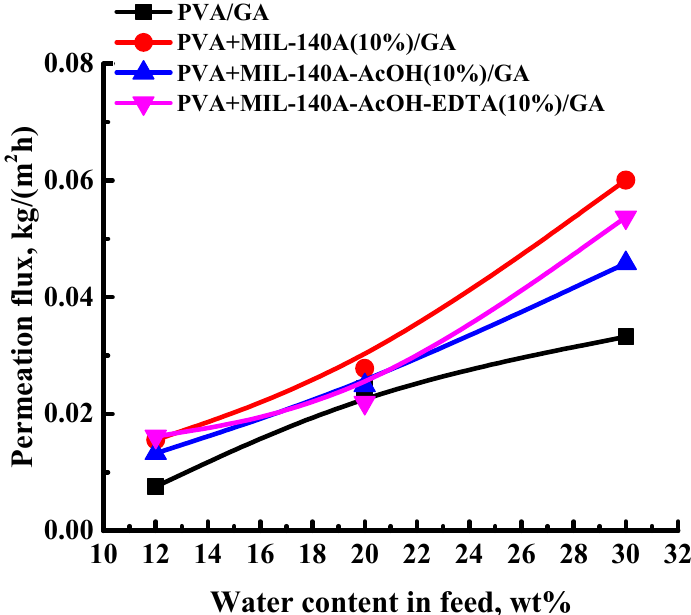
Figure 3. The dependence of the permeation flux on the water content in the feed for the cross-linked PVA and PVA/Zr-MOFs(10%) membranes in pervaporation separation of water/isopropanol mixtures (12, 20, and 30 wt% water) at 22 °C. Water content in the permeate for all cross-linked PVA and PVA/Zr-MOFs(10%) membranes was 99.9 wt%.